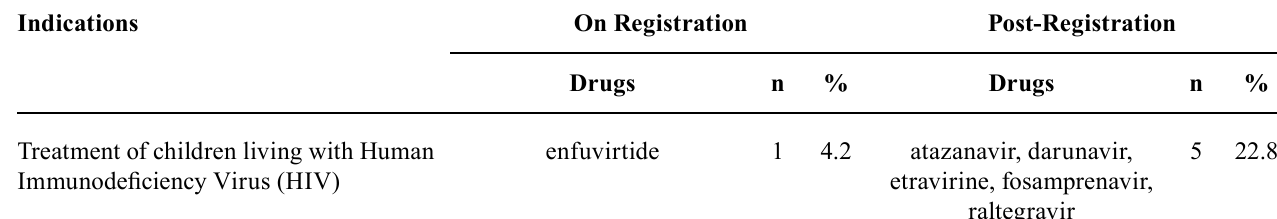
TABLE II – Indication of the 46 medicines with pediatric indication identified in the cohort of new drugs registered from 2003 to 2013